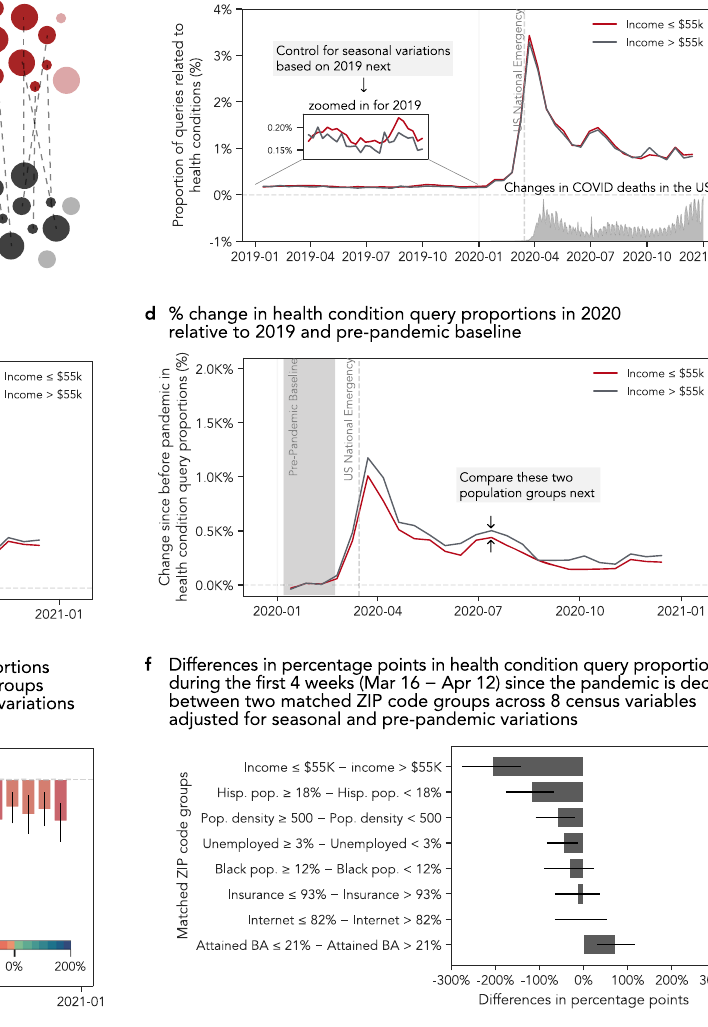
Fig. 1 | Quantifying disparities in online healthinformation access.a 25,150 ZIP codes above and below $ 55,224 medianhouseholdincome are matched to control for other confounding covariates (see Methods). b The proportion of queries relating to a collection of health conditions in 2019 stay well below 0.25% of the total search queries across high-income (gray) and low-income (red) ZIP code groups, with mild seasonal highs around spring and fall and low-income group exhibiting slightly higher health condition query proportion. This proportion increases dramatically to over 3% around the time the US national emergency was declared and is elevated throughout 2020 asCOVID death rates change over time. c Seasonalandweeklyvariationsareaccountedrelativeto2019. d Afteraccounting forpre-pandemicbaseline(relativeto6January-23February2020,shadedingray), we isolate the percent change in health condition query proportions introduced during the pandemic where the differences between high- and low-income